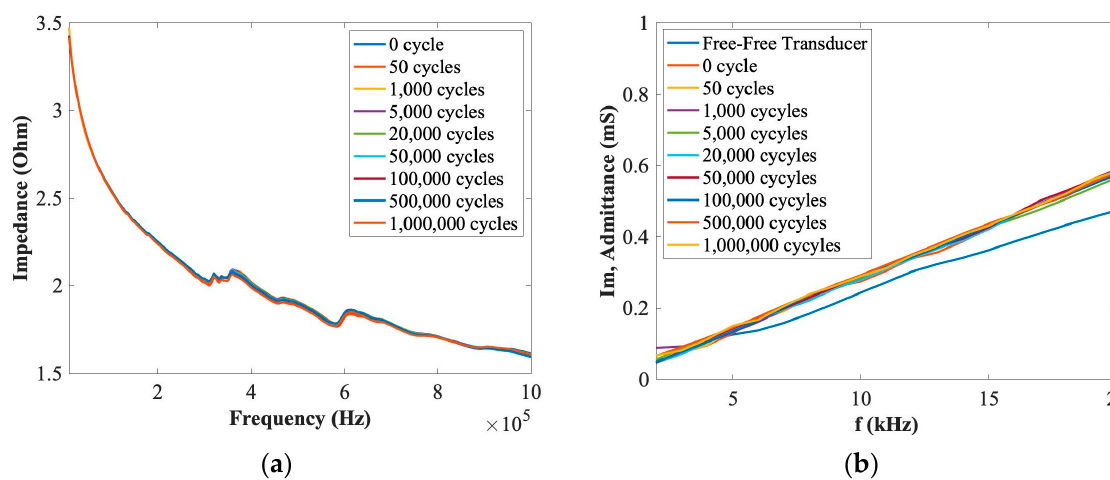
Figure 5. EMI properties of ( a ) impedance and ( b ) the imaginary part of admittance for the embedded PZT transducer under the force range of 0.5~5 kN.